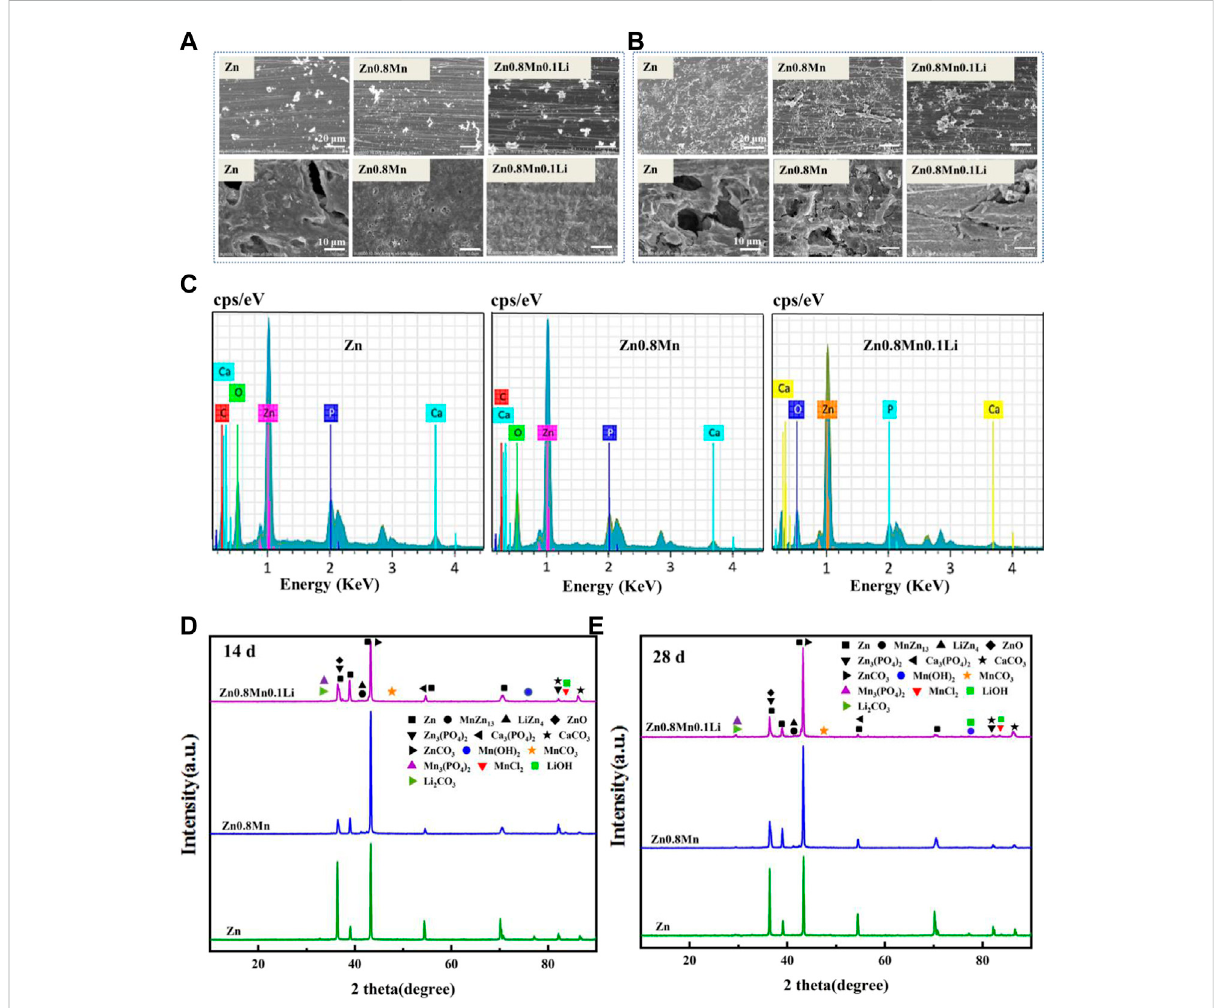
FIGURE 5 Invitro degradationtests. (A) DegradationmorphologyunderFESEMafter14 daysimmersioninSBF. (B) DegradationmorphologyunderFESEM after28 daysimmersioninSBF. (C) TheEDSspectraofZn,Zn0.8Mn,andZn0.8Mn0.1Liafter28 daysimmersioninSBF. (D) XRDdiffractionpatternsof degradation products after 14 days immersion in SBF. (E) XRD diffraction patterns of degradation products after 28 days immersion in